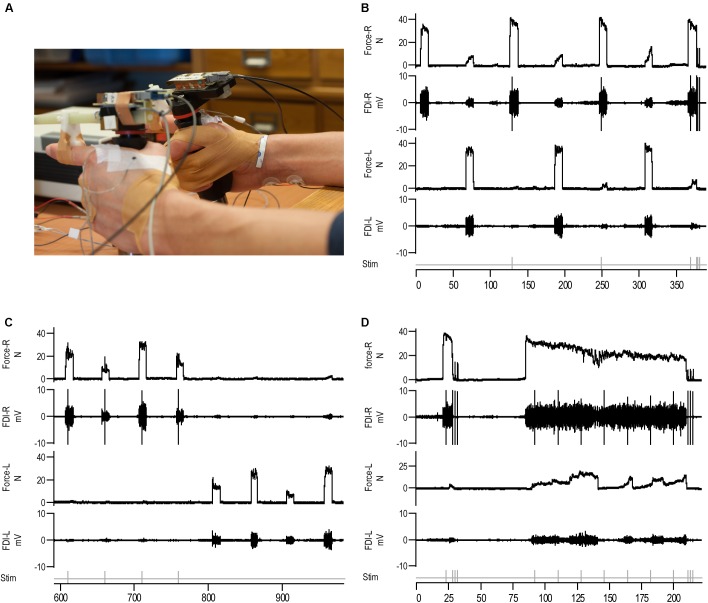
Illustration of the force transducer and an overview of the motor tasks as illustrated by data of an individual subject (female, 64 years old). (A) Photo of the hands holding the force transducers. EMG electrodes were taped to the muscle belly of the FDI and close to the second metacarpal joint. Stimulation electrodes were placed on the ulnar nerve of the right forearm, one electrode at and a second electrode approximately two centimeters proximal from the wrist. (B) An example of four right and three left maximal voluntary contractions (MVCs) at baseline. Subjects alternated between the right and left hand. Electrical stimulation (stim) was applied to the ulnar nerve during the MVCs with the right hand and at rest (during the first stimulus the subject was not at rest yet). (C) Submaximal contractions with the left and right FDI at four different levels (10, 30, 50, and 70% MVC). During each contraction with the right FDI, electrical stimulation was applied to the ulnar nerve. (D) Brief MVC with electrical stimulation of the ulnar nerve, followed by two to three stimuli at rest. After 60 s rest, subjects performed a sustained MVC for 124 s. During this sustained contraction seven stimuli were applied to the ulnar nerve (18 s interval). Following the sustained contraction three doublet-forces were evoked at rest.